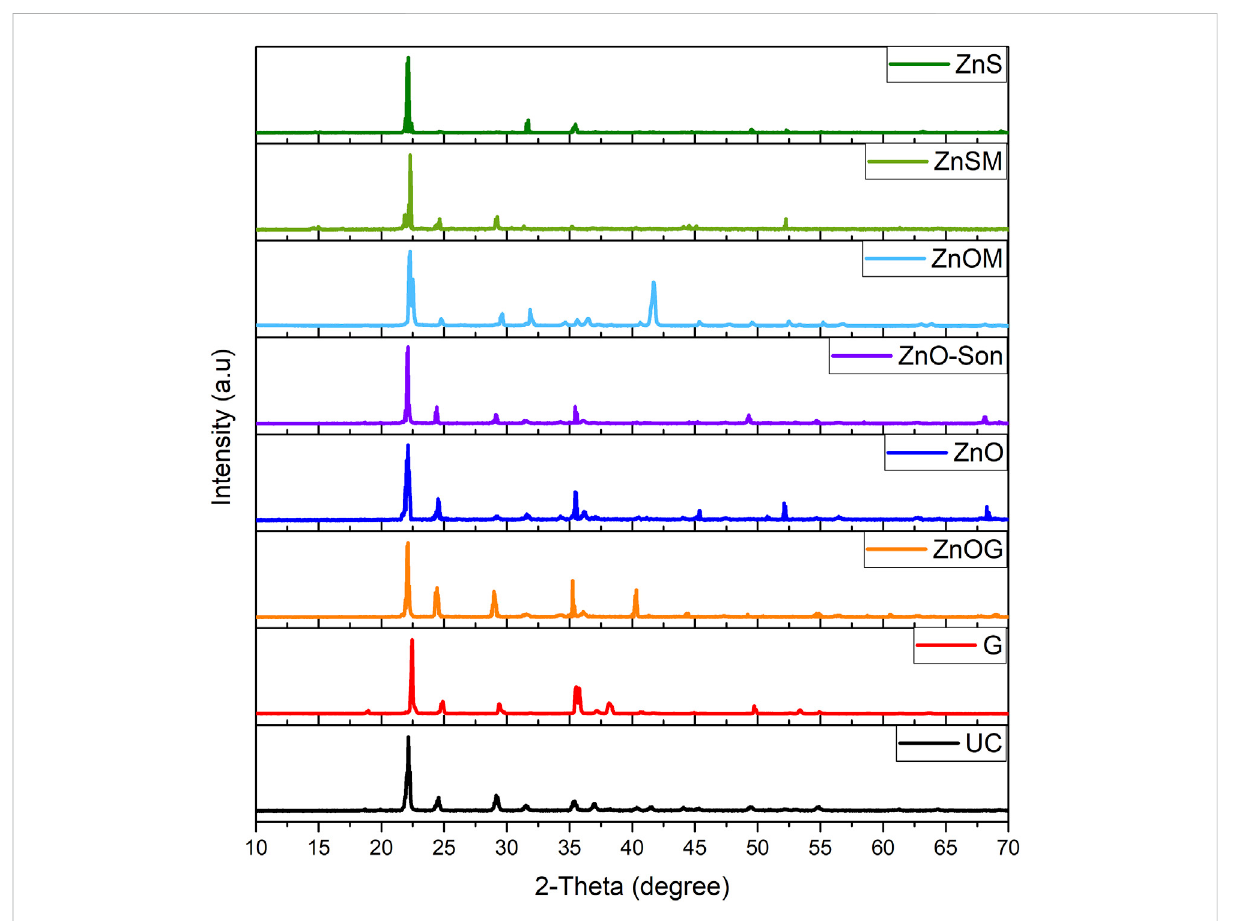
FIGURE 3 XRD images of fertilizer samples, namely, UC, G, ZnOG, ZnO, ZnO-Son, ZnOM, ZnSM, and